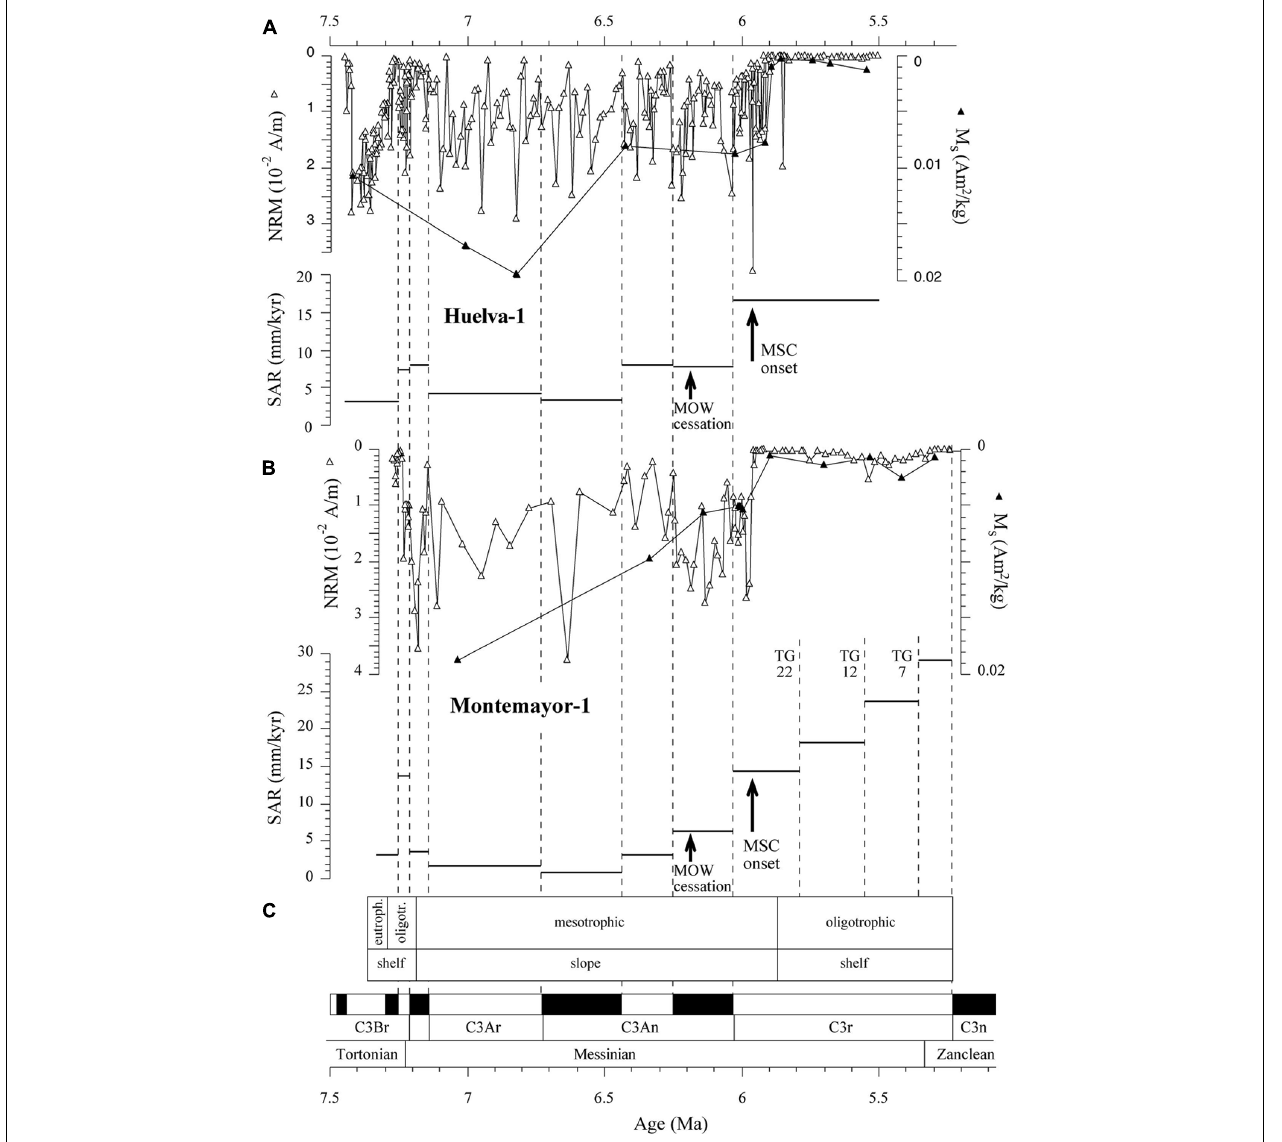
FIGURE 10 | NRM, M s and sediment accumulation rate (SAR) variations as a function of age for the Huelva-1 (A) and Montemayor-1 (B) boreholes, shown with trophic conditions and depositional context (C) inferred from benthic foraminiferal assemblages in the Montemayor-1 borehole (Pérez-Asensio, 2012;